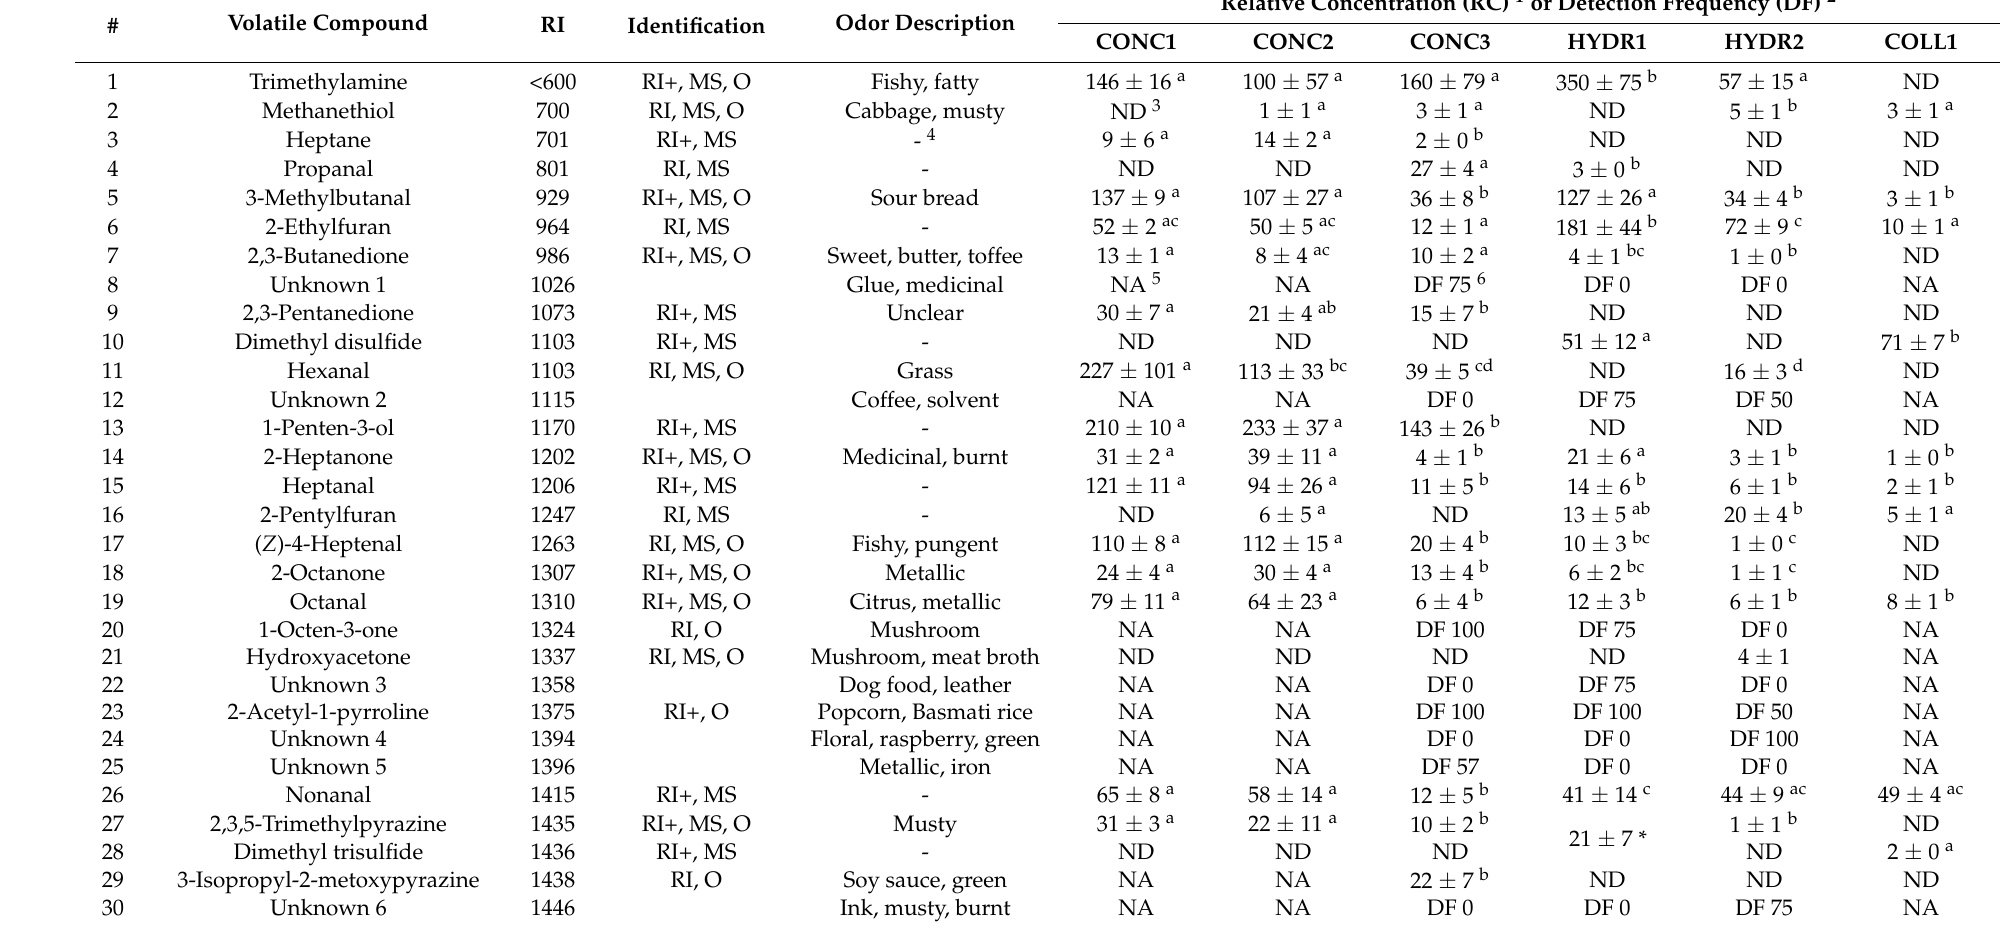
Table 8. Relative concentration (mean ± standard deviation) of different odor-active volatile compounds identified with GC-MS-O and previous literature from commercial fish protein concentrates, hydrolysates, and hydrolyzed collagen. The RI was determined with polar WF-Wax column. The identification is marked with RI+, if the compound could be identified also with non-polar DB-5 column. Different letters within the same row indicate a statistically significant difference with ANOVA post hoc pair comparison ( p <